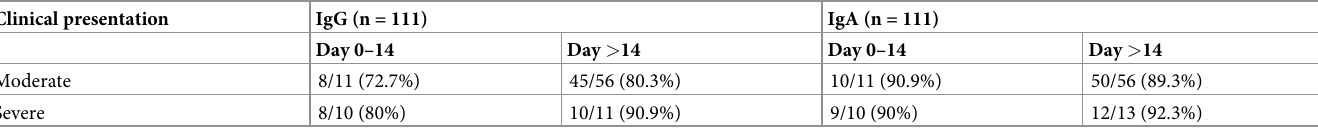
Table 5. EUROIMMUN Anti-SARS-CoV-2 IgA and IgG assays sensitivity stratified by days post-PCR diagnosis or symptom onset compared with In-house